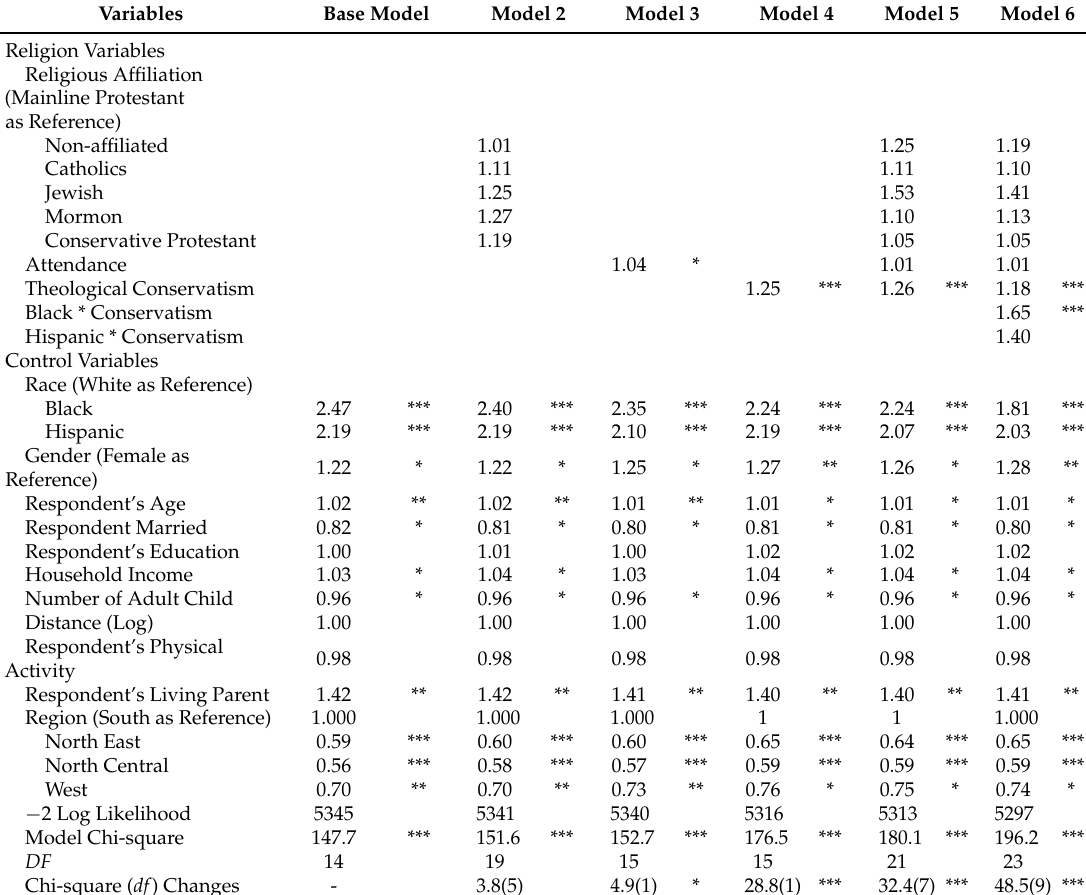
Table 4. Odds Coefficients of Ordered Logistic Regressions to Predict Children Ought to Provide Financial Aid ( n =